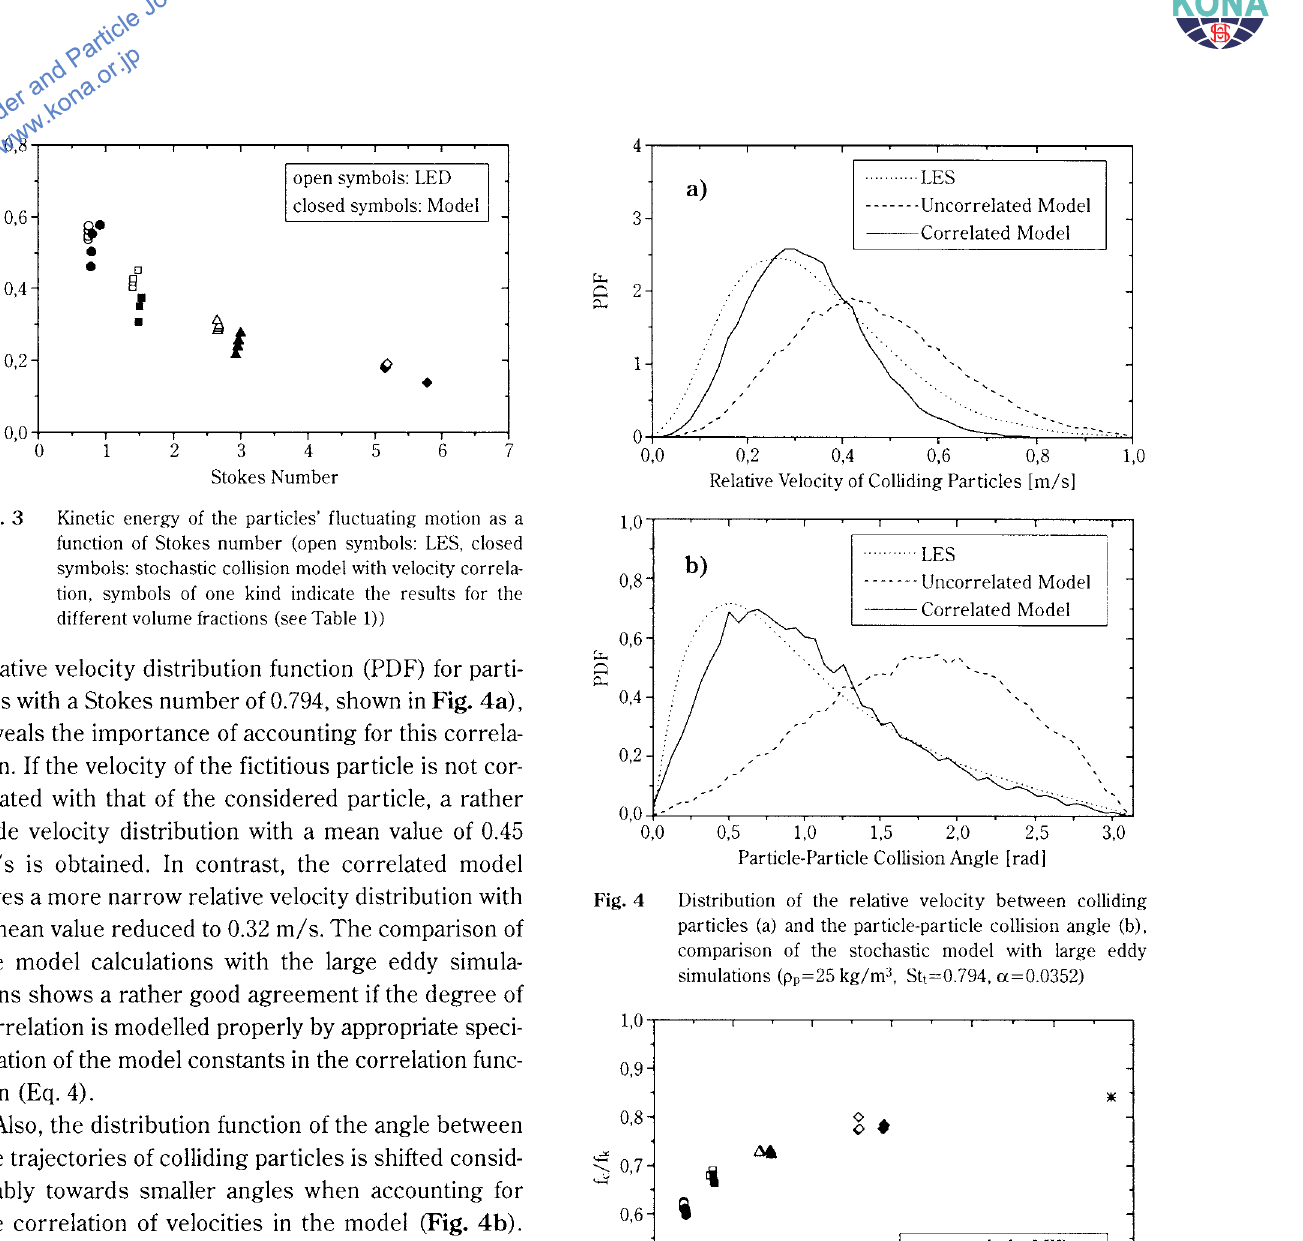
wide velocity distribution with a mean value of 0.45